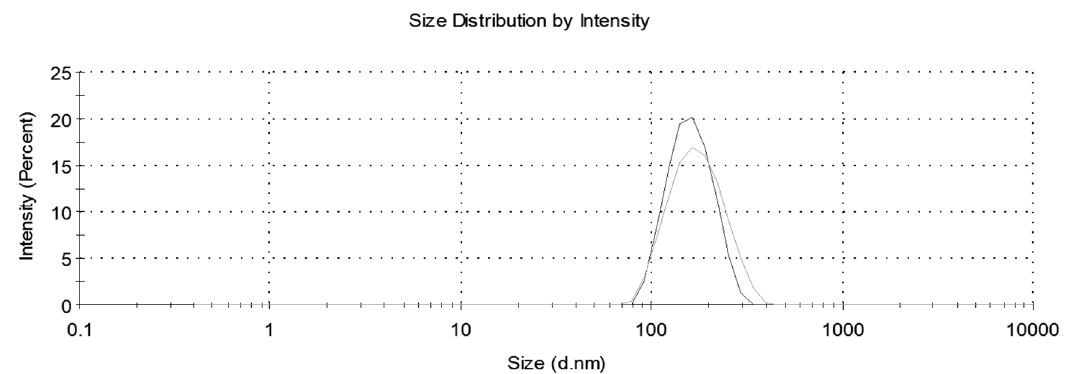
Figure 6. Particle size distribution of nanoplastic particles (Nano ZS Zetasizer) following centrifugation (time = 10 min). Lines indicate replicate results.